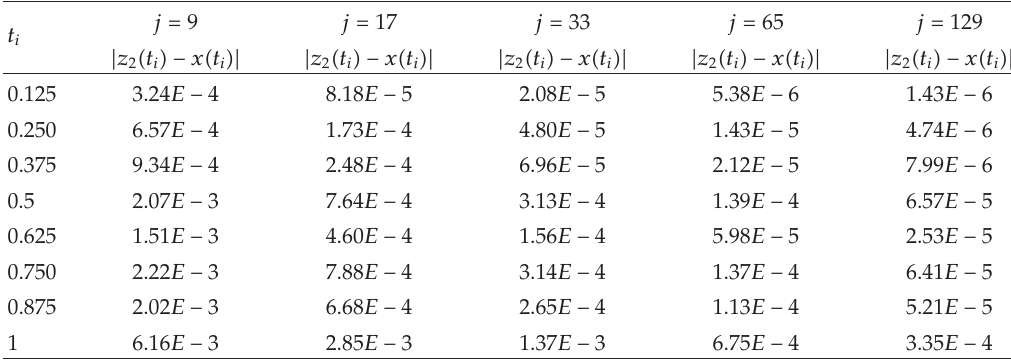
Table 3: Absolute errors for Example